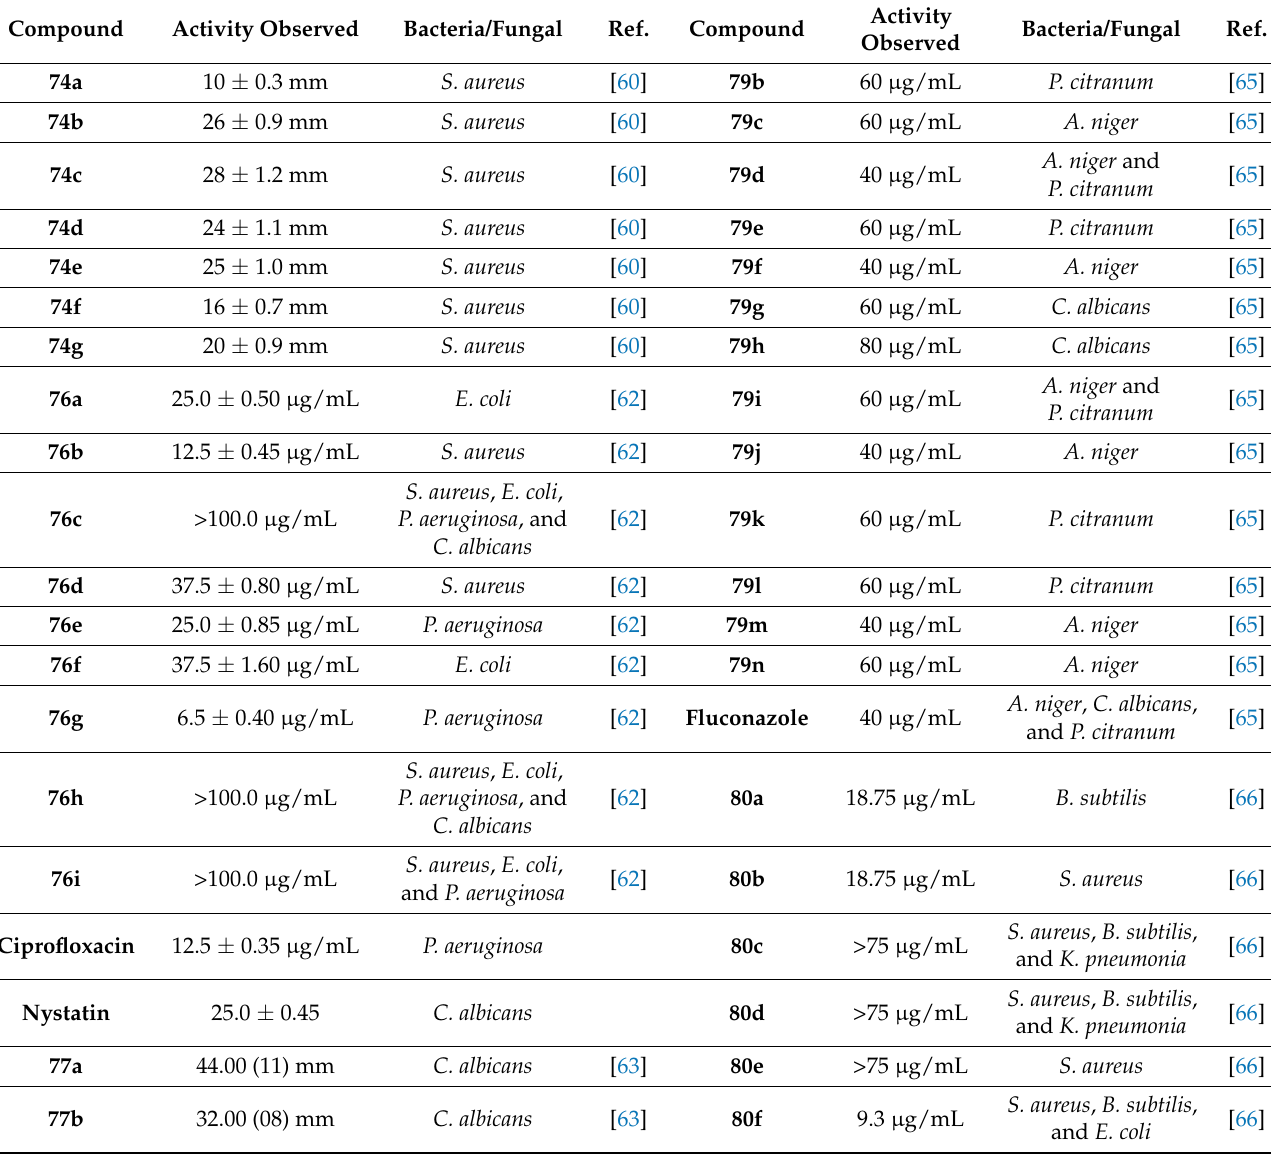
Table 6. Antimicrobial activity data of reported coumarin triazole derivatives. Compound Activity Observed Bacteria/Fungal Ref. Compound